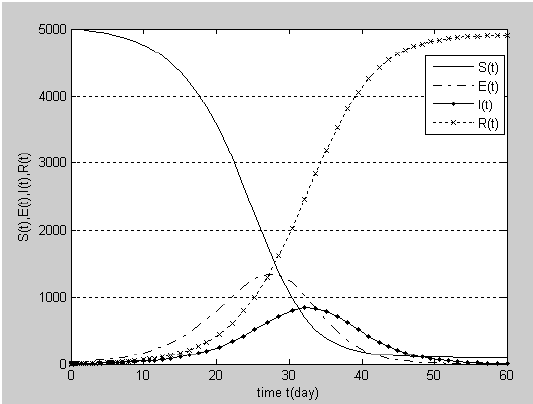
Figure 3. Solution of the SEIRS epidemic diffusion model (EDH